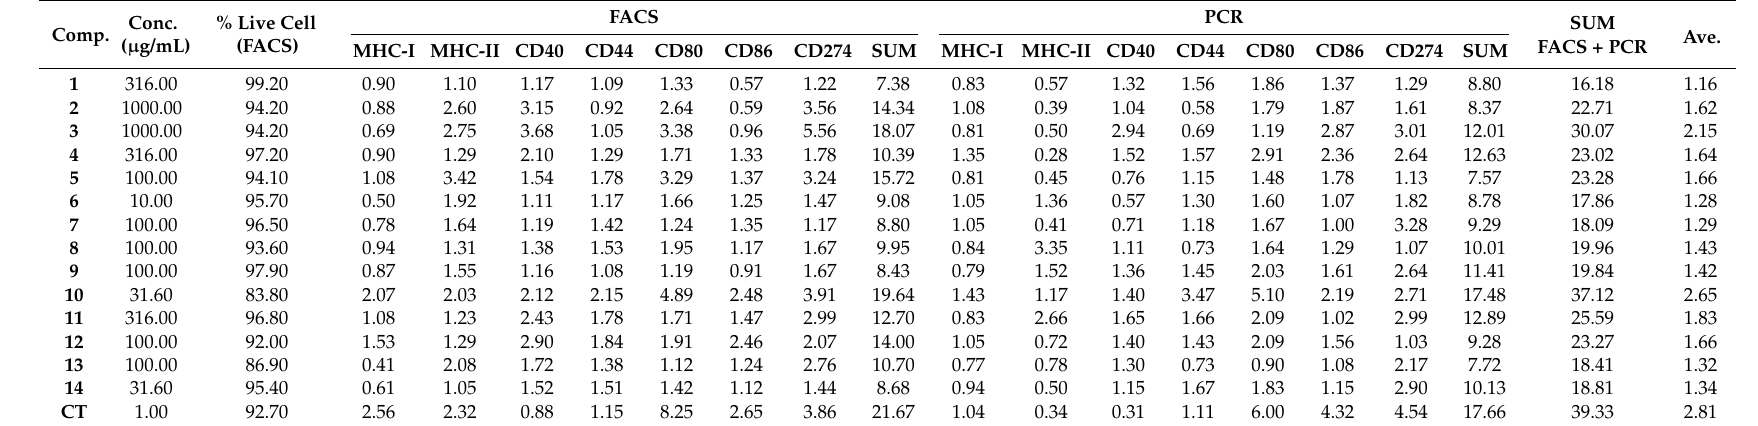
Table 2. Immunomodulatory bioactivity of 14 plant compounds in DC2.4 dendritic cell line (FACS, PCR, SUM and